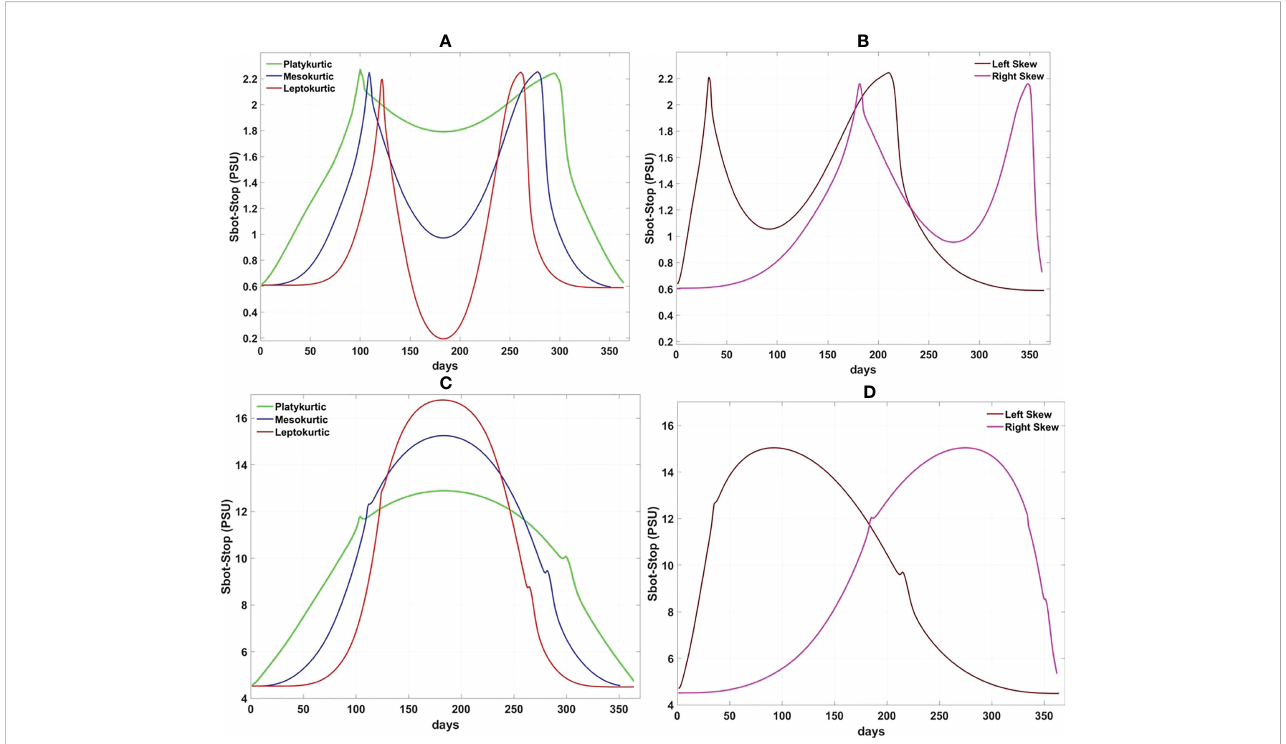
FIGURE 5 (A, B) The evolution in time of the top to bottom layer difference of the radially averaged salinity in a distance 3 km from the mouth in the symmetric and skewed fl ow distributions respectively. (C, D) The evolution in time of the top to bottom layer difference of the radially averaged salinity in a distance 5 km from the mouth in the symmetric and skewed fl ow distributions